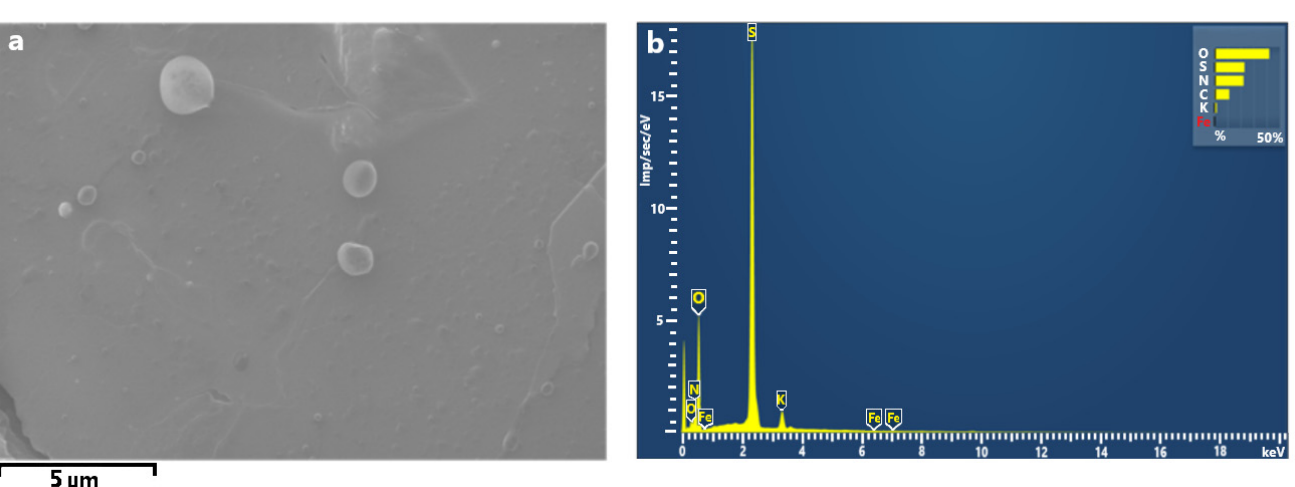
Figure 4. ( a ) SEM micrograph (magnification 500×), ( b ) chemical mapping of the most abundant elements, and ( c ) EDS spectrum of aggregate particles from the aluminosilicate group ( d ), maps rod- like particles consisting of K, Ca, S, and O that could be potassium and calcium sulfates ( e ), and plates consisting of Fe-Mg-enriched aluminosilicates.